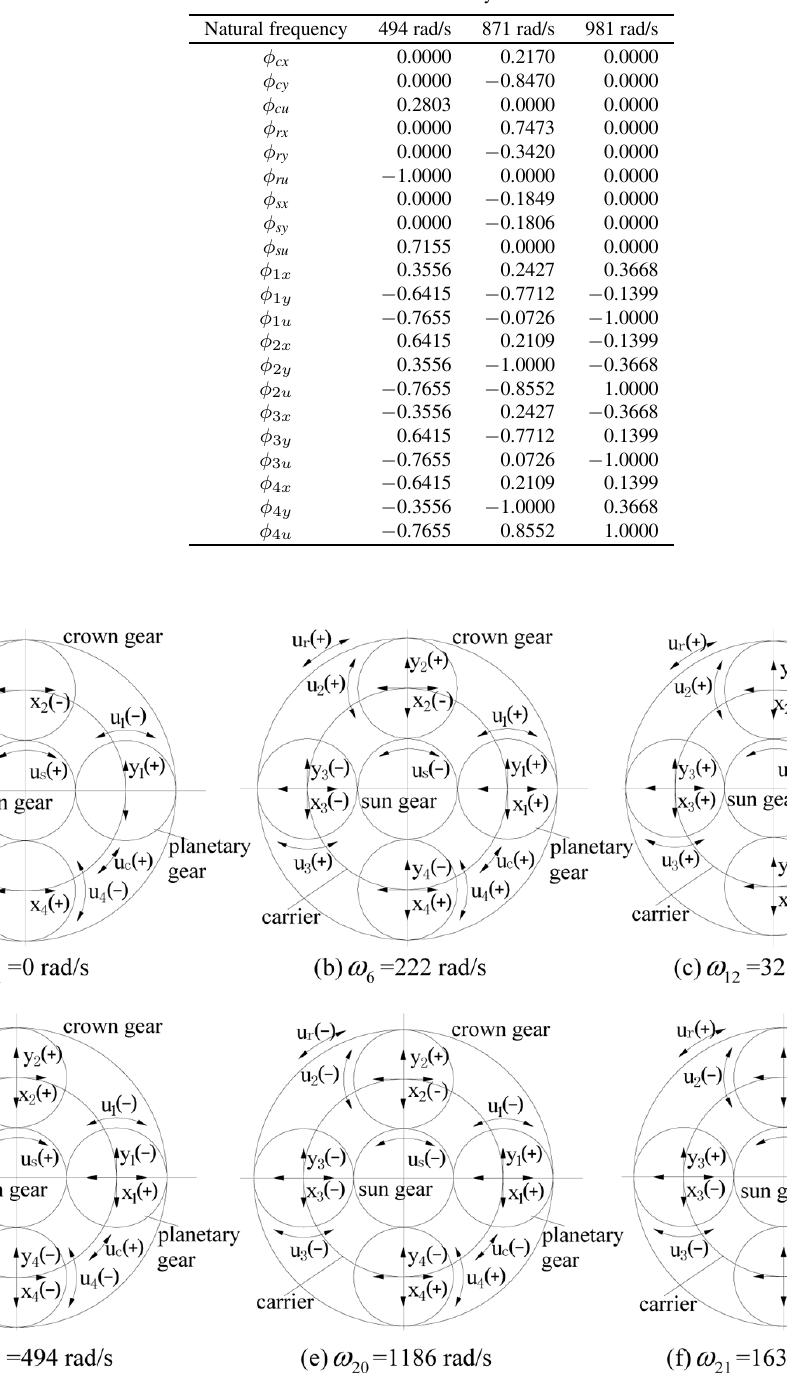
Fig. 4. Torsion modes of the central elements ( N =